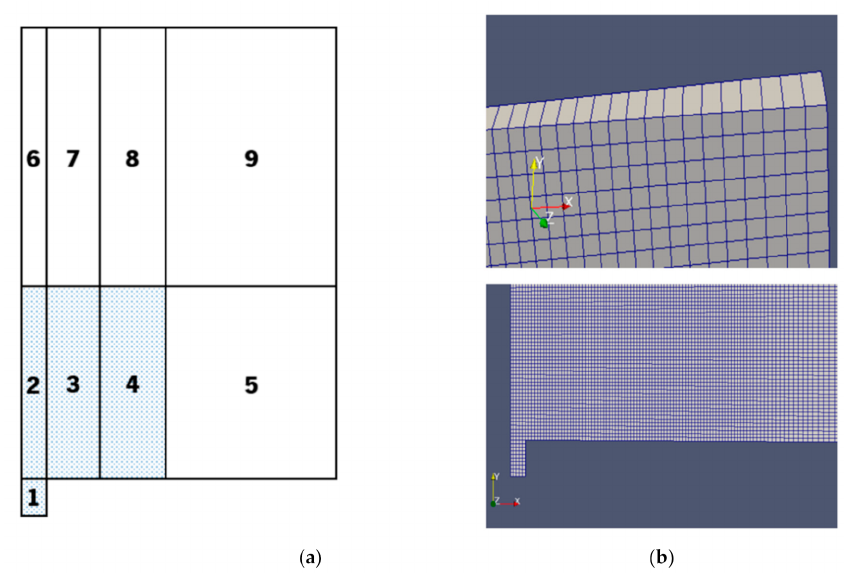
Figure 5. Mesh definition. ( a ) Different mesh zones of the domain. ( b ) Mesh details.